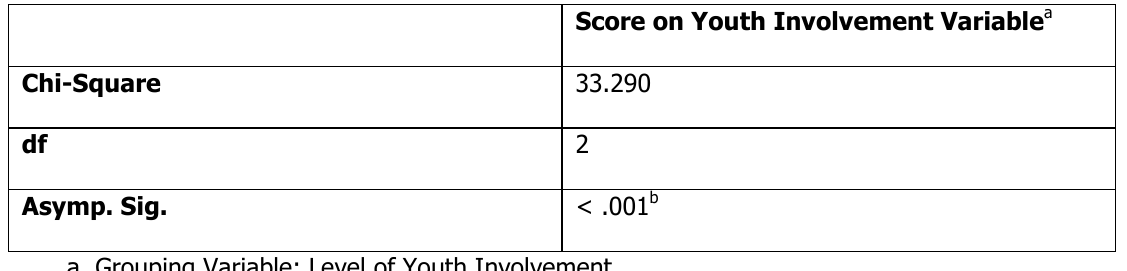
Kruskal-Wallis test for median differences among high, medium, low levels of youth involvement, Alachua County, Florida, 2006.